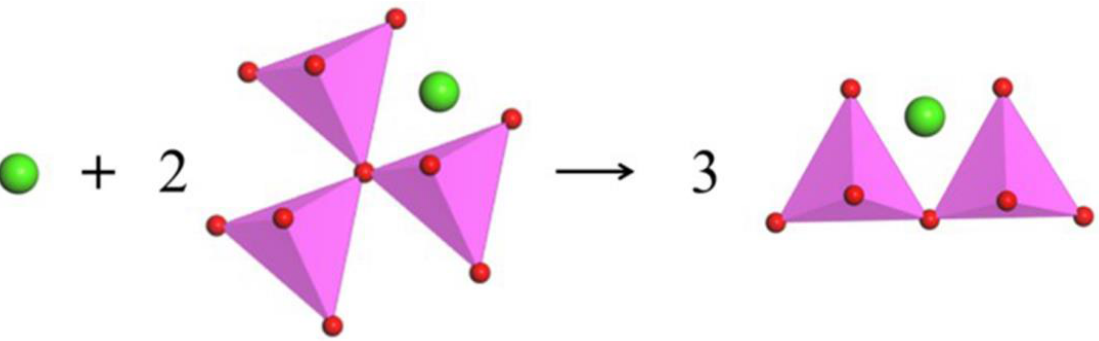
Figure 4. Distribution of oxygen types in CaO – Al 2 O 3 – B 2 O 3 melts with different CaO/Al 2 O 3 mole ratios: ( a ) the initial distribution; ( b ) the refined distribution of networked structural oxygen; ( c ) the refined distribution of nonbridging oxygen and bridging oxygen.